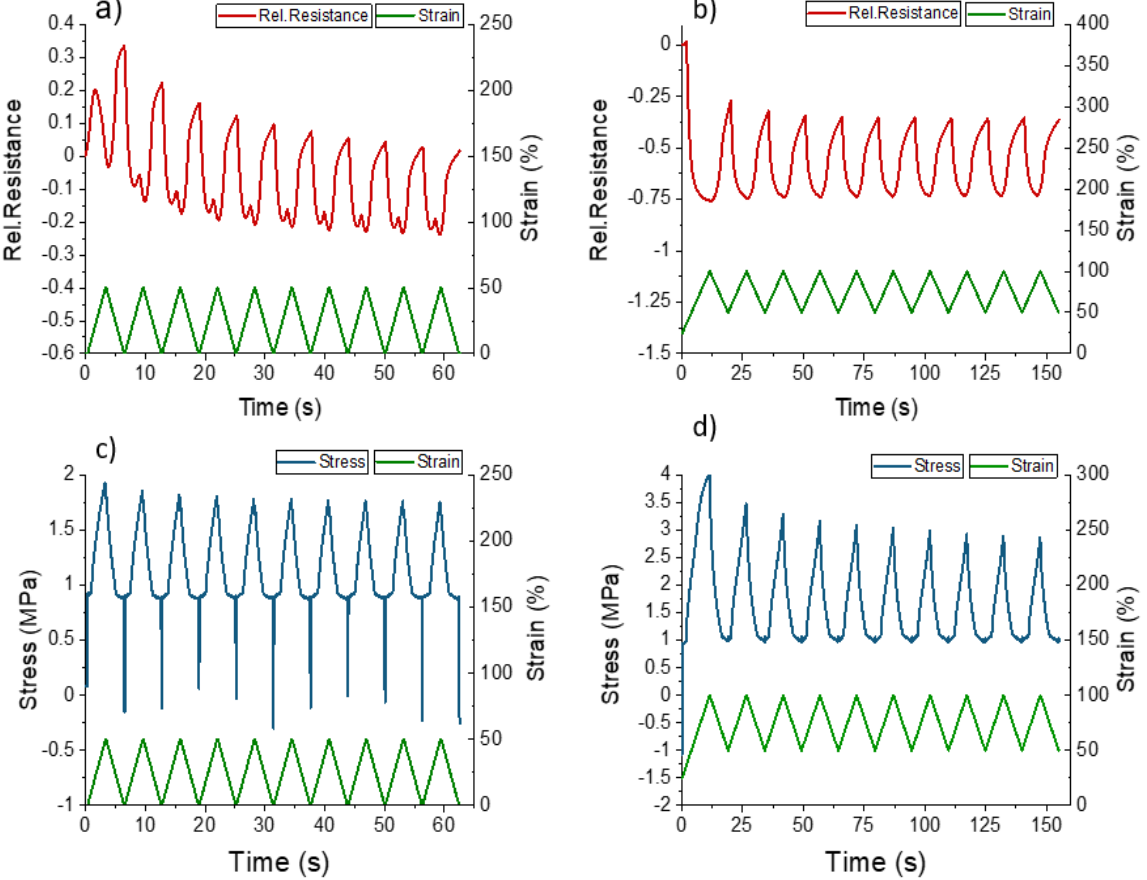
Figure 6. Response of the mechanical stress and electrical signal during dynamic tensile testing of the ShSF between 0 and 50% ( a , c ) and 50 and 100% strain ( b , d ).